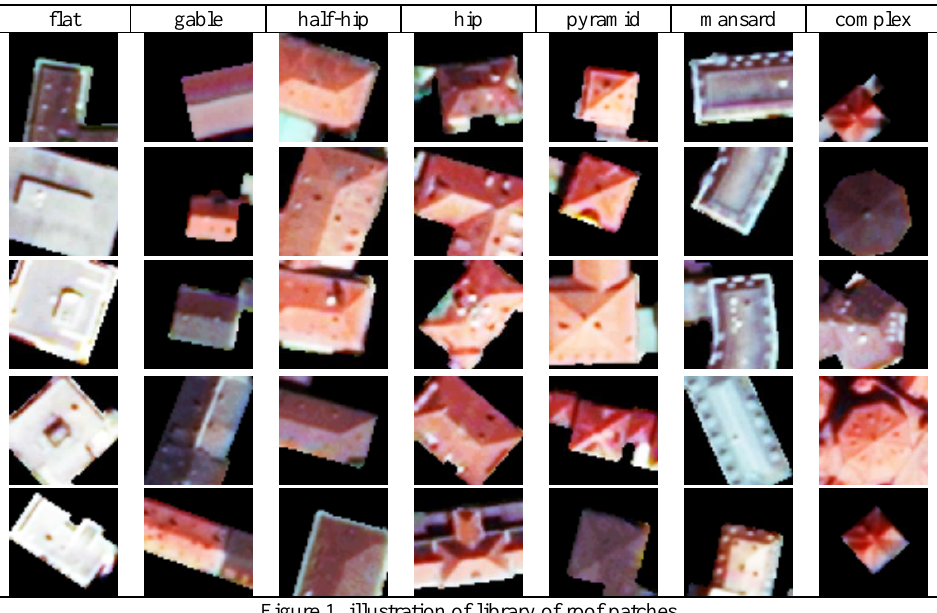
Figure 1. illustration of library of roof patches